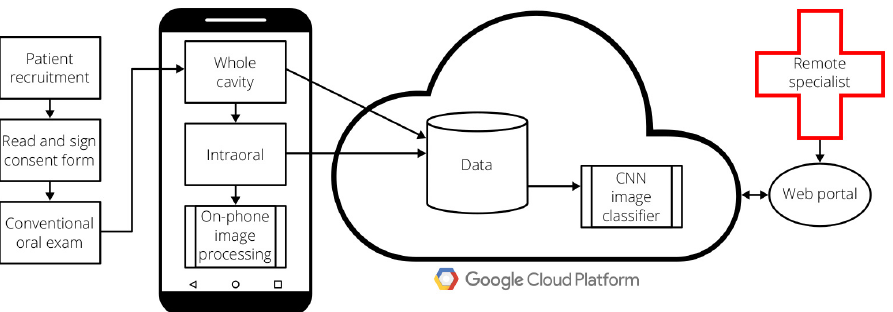
Fig 8. Field testing workflow for smartphone-based oral